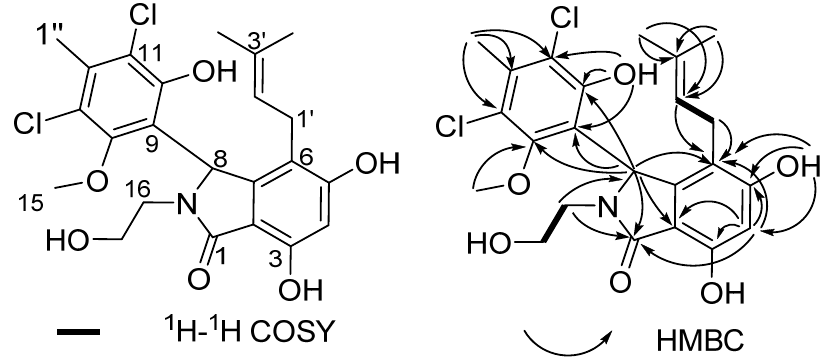
Figure 4. The planar structure and key 2D NMR correlations of 1a . HMBC correlations from H-1” to C-11, C-12, and C-13, from the phenolic proton at δ 10.03 to C-9, C-10, and C-11, from the methoxy protons at δ 3.05 to C-14, from H-8 to C-9, C-10, and C-14 indicated that a hexasubstituted benzene ring was attached to C-8 via a C-C bond. As a result, the two chlorine atoms in 1a could only be located at C-11 and C-13. Therefore, the planar structure of 1a was assembled as shown in Figure